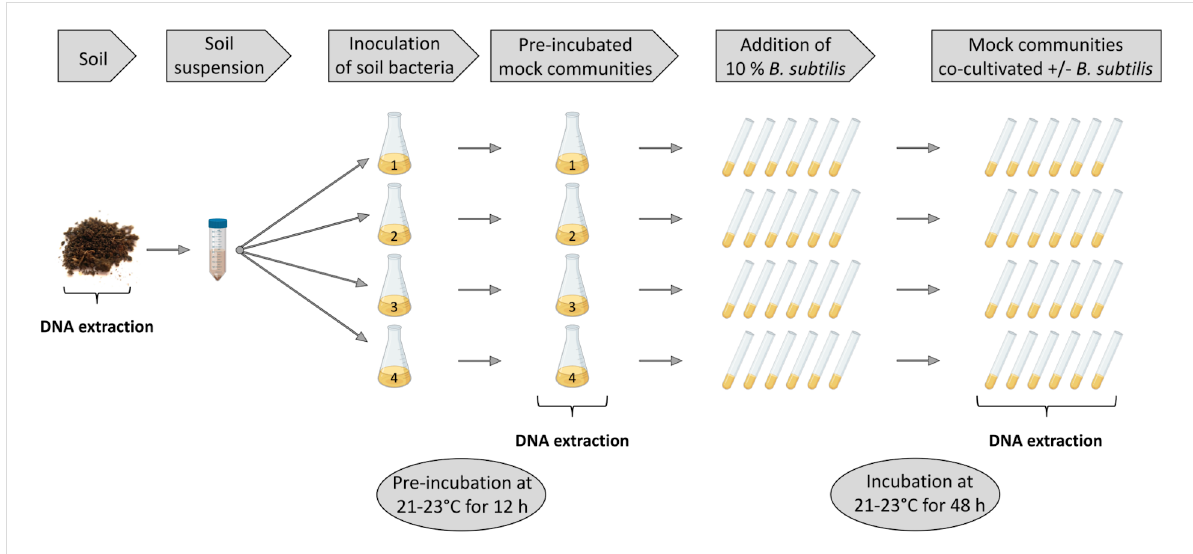
Figure 2: Overview of the experimental setup. A soil suspension, obtained from a soil sample, was used as an inoculum for four independent repli- cates and preincubated for 12 h. Enriched precultures were aliquoted and supplemented with 10% B. subtilis strains or left untreated and incubated for 48 h. DNA was extracted from the soil sample, preincubated soil suspensions, and mock communities. Parts of this figure were created using BioRender.com.